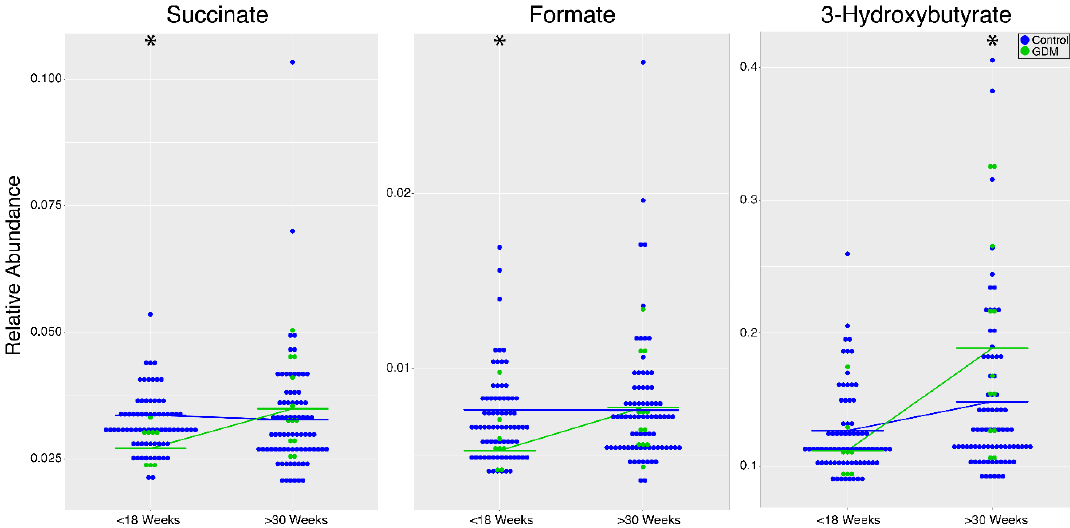
Figure 4. Dot plots of metabolites with interaction effects for GDM ( n = 8, <18 weeks; n = 12, >30 weeks; green) compared to non-diabetic controls ( n = 74, <18 weeks; n = 77, >30 weeks; blue) during pregnancy. Significant interactions ( p < 0.05) between GDM and controls are represented by stars. Results for all metabolites that displayed significant interaction effects are listed in Table